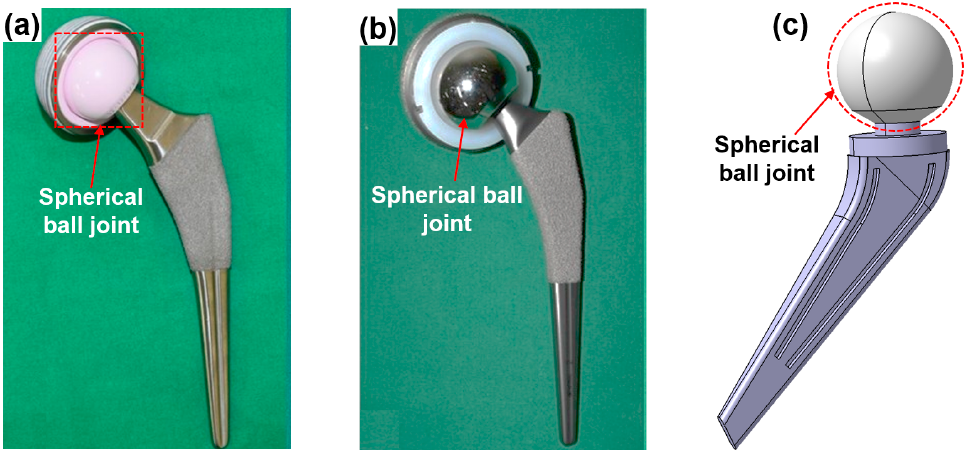
Figure 13. Artificial hip joint used in medical applications: ( a ) ceramic spherical ball joint, ( b ) metal spherical ball joint, and ( c ) schematic view of spherical ball joint. Data obtained from Hu et al. [109]. CC BY license.